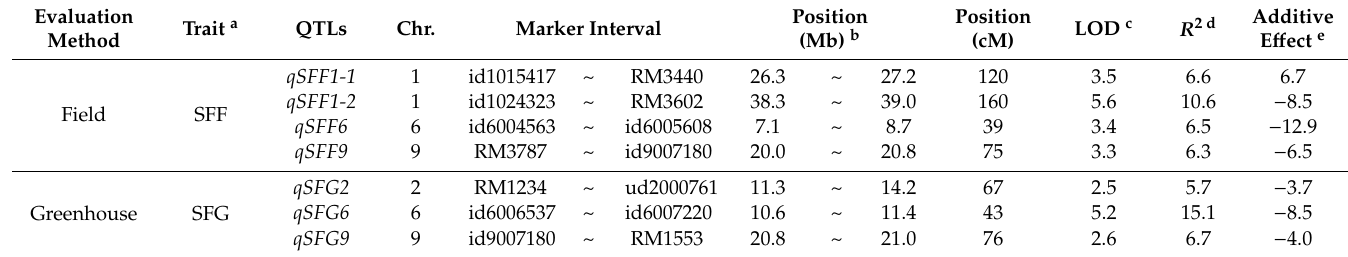
Table 5. QTL for spikelet fertility under cold treatment in the field and greenhouse conditions determined by composite interval mapping.